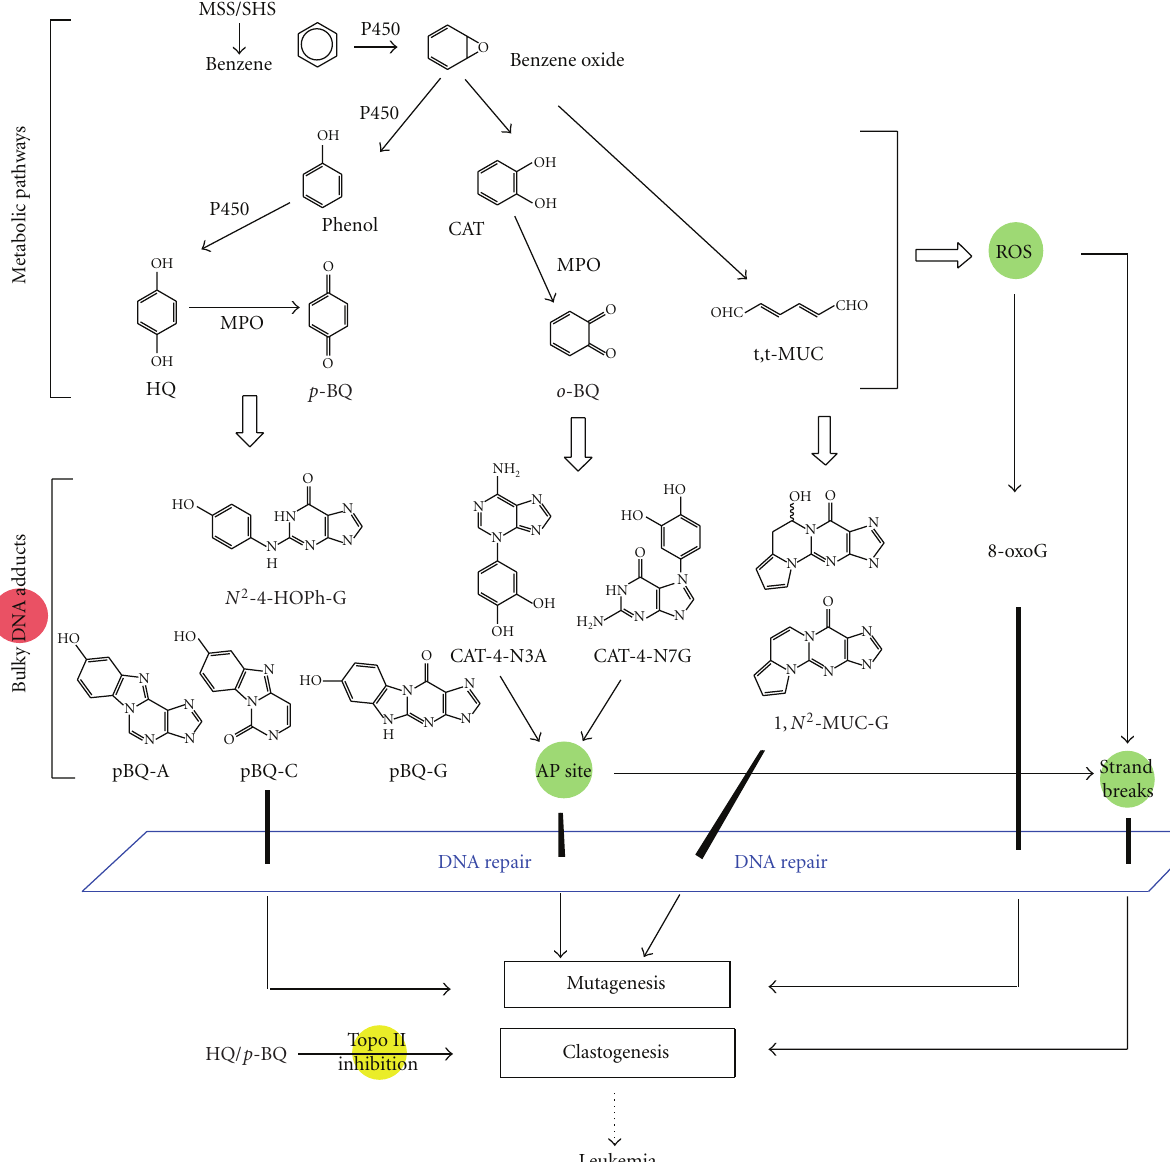
Figure 4: Multiple benzene metabolites, di ff erent types of DNA lesions, and proposed biological e ff ects. Benzene has a complex metabolism and the listed metabolites are not a complete list. The adducts formed include those identified in vitro and in vivo , stable and unstable, bulky and oxidized adducts. DSBs are one of the most severe DNA lesions caused directly and indirectly by benzene metabolites. Repair of benzene-DNA adducts may include multiple mechanisms such as BER, NER, and NIR. Only those adducts that finally escape all the defense mechanisms such as repair, or are misrepaired, may lead to mutations. Persistence or coexistence of di ff erent types of lesions could form a broad-based attack on the genomic stability. It is also known that a number of benzene metabolites can inhibit topoisomerase II (topo II) activity, which may represent a potential mechanism for benzene’s clastogenic e ff ects